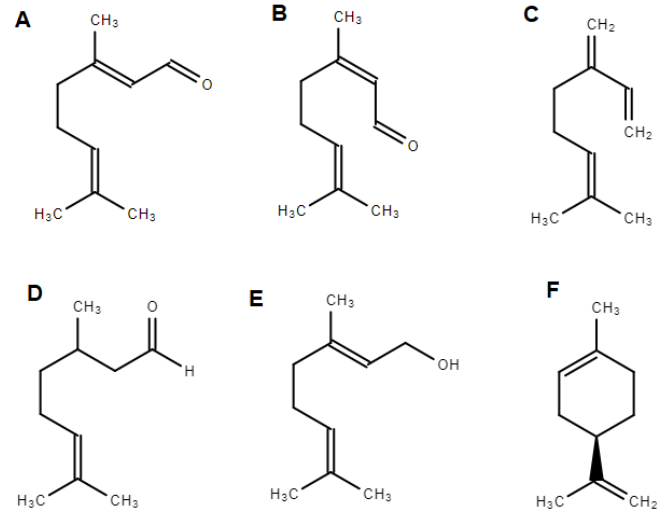
Figure 2. Chemical structures of the most prevalent bioactive compounds identified in lemongrass essential oil: geranial ( A ) and neral ( B ), whose mixture constitutes citral, β -myrcene ( C ), citronellal ( D ), geraniol ( E ) and limonene ( F ). These structures were drawn by Chem Spider Draw software. Typically, lemongrass extracts are made using water (infusions and decoctions),